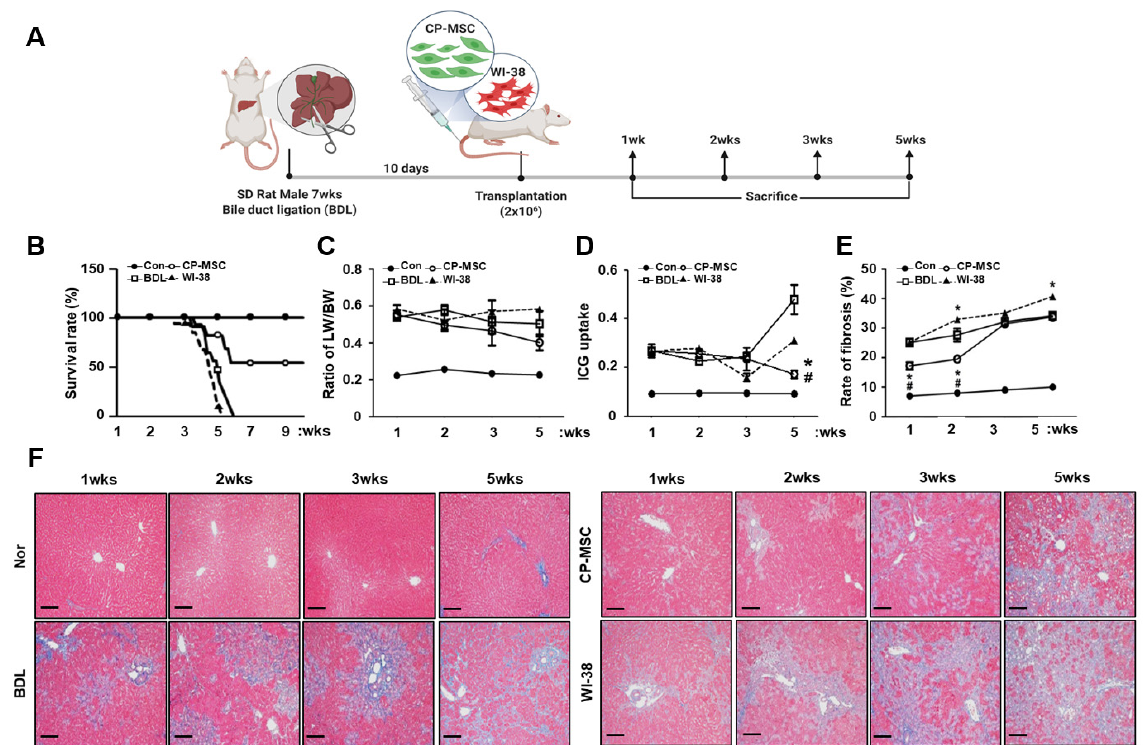
Figure 2. Engrafted CP ‐ MSCs promote liver function in the liver injury rat model with BDL. ( A ) A schematic diagram describing the rat model of BDL. After BDL, the cells (CP ‐ MSCs and WI ‐ 38; 2 × 10 6 ) were transplanted into the rats via the tail vein, and the animals were sacrificed at 1, 2, 3, and 5 weeks. ( B ) The survival curve of rats in 4 groups (Con, BDL, CP ‐ MSCs and WI ‐ 38 group) over 10 weeks. The rat survival rate was monitored daily and is expressed by Kaplan–Meier survival curves. ( C ) Liver/body weight ratios were determined, and ( D ) an ICG clearance test was performed in the control group (Con), the BDL group (BDL), the CP ‐ MSC transplantation group (CP ‐ MSCs), and the WI ‐ 38 transplantation group (WI ‐ 38) at 1, 2, 3, and 5 weeks after cell transplantation. ( E ) The ratio of fibrotic/normal hepatocytes was analyzed by the fibrosis scoring system using ImageJ software through ( F ) Masson’s trichrome staining. Each experiment was repeated at least three times. The data are expressed as the mean ± SEM (* p < 0.05 compared with the BDL group; # p < 0.05 compared with the WI ‐ 38transplantation group). The scale bar represents 75 μ m.